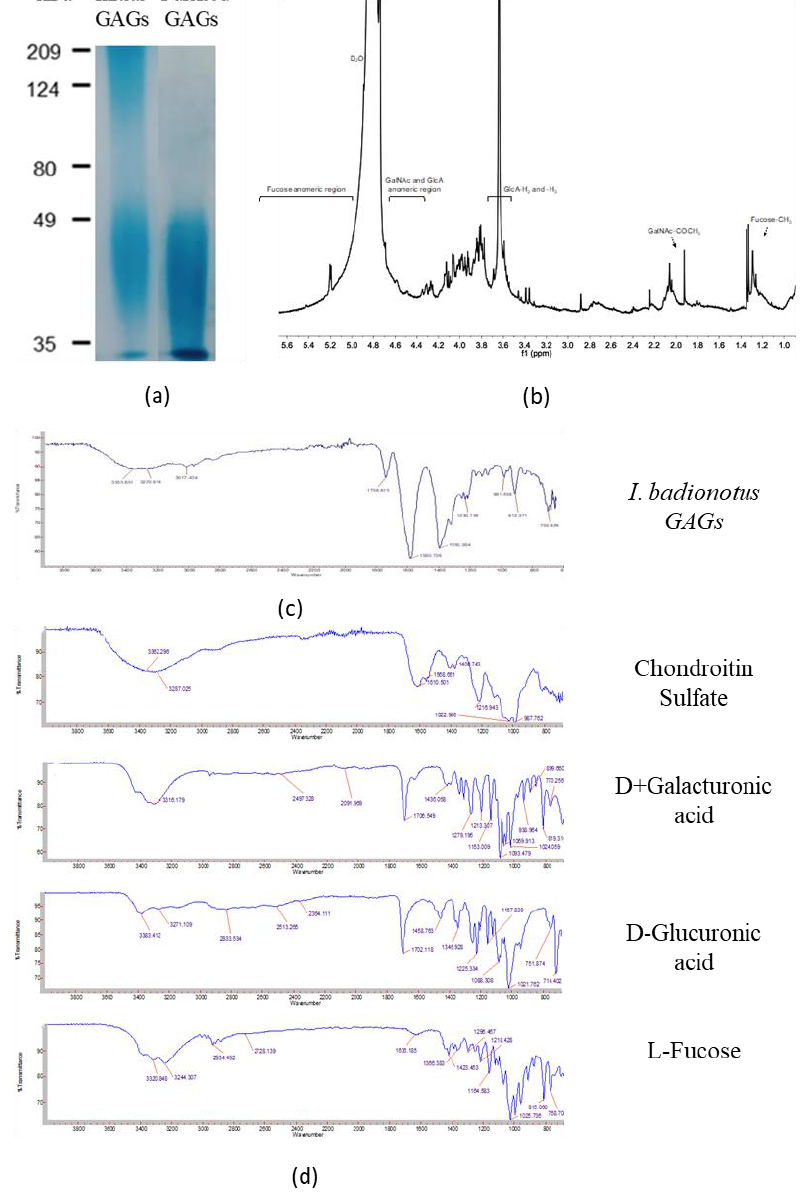
Figure 2. GAGs preparation isolated from I. badionotus body wall. ( a ) Alcian Blue-stained polyacrylamide gel electrophoretogram of initial and purified GAGs from sea cucumber ( I. badionotus ). ( b ) 1H NMR spectra at 600 MHz of fucosylated chondroitin sulfate of sea cucumber ( I. badionatus ). ( c ) Infrared spectra of GAGs from sea cucumber ( I. badionotus ). ( d ) Overlay comparing GAGs to standards.